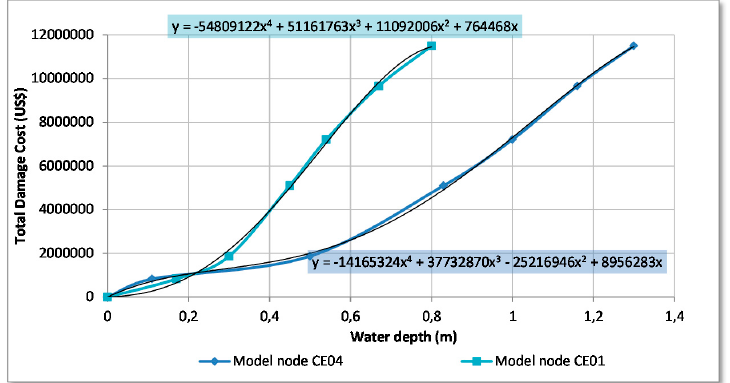
Figure 8. Damage cost per house and per flooding vs. water depth at the house—Quitacalzones.